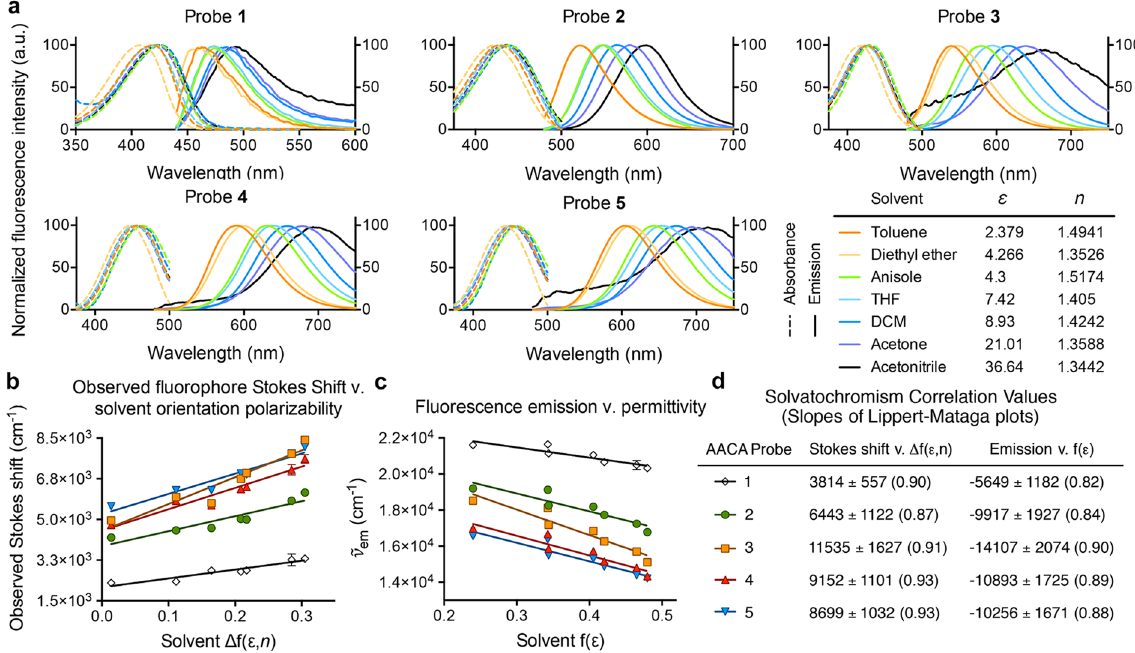
Figure 3. Solvatochromic properties of AACA probes 1–5 in polar aprotic solvents. ( a ) Absorption and fluorescence emission spectra of the fluorophores in select solvents show positive solvatochromism. ( b ) Lippert- Mataga plot of the observed stokes shift (in wavenumbers) as a function of the solvent orientation polarizability, Δ f( ε , n ). ( c ) Plot of solvatochromism fit to equation (2), where the observed fluorescence emission (in wavenumbers) as a function of solvent permittivity supports that the emission bands are not highly dependent on the environment refractive index. ( d ) Tabulated slopes of the Lippert-Mataga plots ( b ) and ( c ) and the linear regression coefficient (R 2 ) in parenthesis. Slope values are in wavenumbers per unit